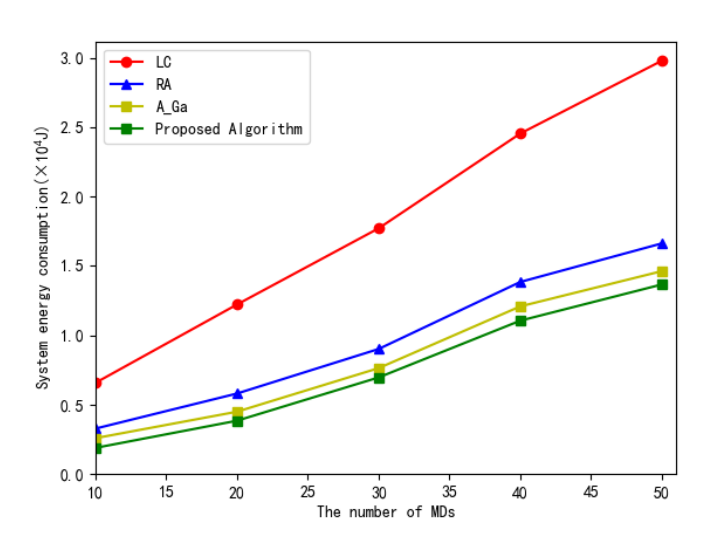
Figure 9. The total system energy consumption versus the number of